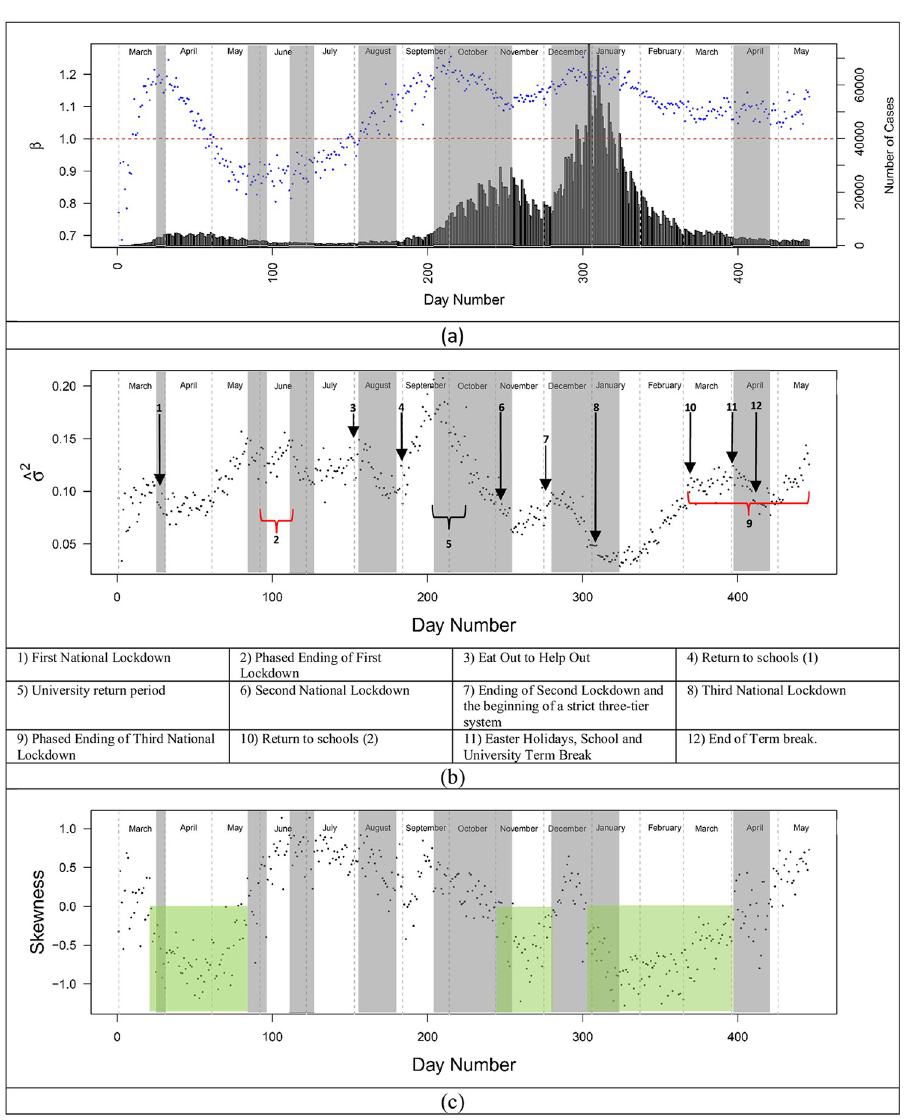
Fig 4. Daily time series of scaling exponent and residual variance and skewness for cases between 01/03/2020 and 11/01/2021. (a) Time series of daily scaling exponent of COVID-19 cases, (b) residual variance, and (c) residual skewness. The horizontal line in (a) indicates linear scaling. The bar chart indicates raw daily cases. The grey shading indicates periods of homogenisation. The green shaded periods in (c) correspond to negatively skewed residuals. Those regions coincide with periods of time where isolation dominate during the three national lockdowns. The remaining times were dominated by spreading (positively skewed residuals). Arrows indicate key dates/time periods and red curly brackets represent phased endings to lockdowns. The national restrictions in Wales preceded England beginning on 20/10/2020.